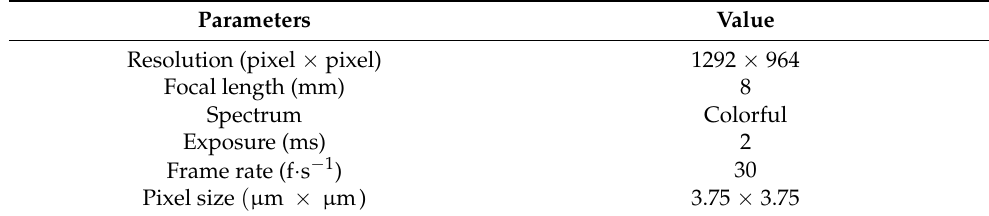
Table 1. Parameters of the monocular camera